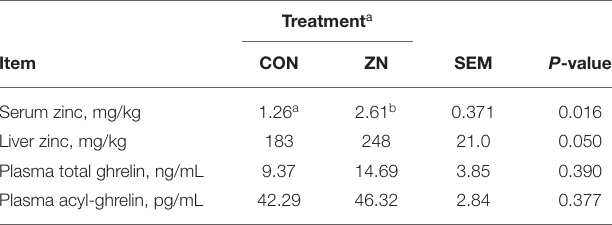
TABLE 5 | Plasma total ghrelin and acyl-ghrelin of pigs in a fasted state following 4 d of a zinc oxide bolus (ZN) or a saline bolus (CON) drench (Expt. 2). Treatment